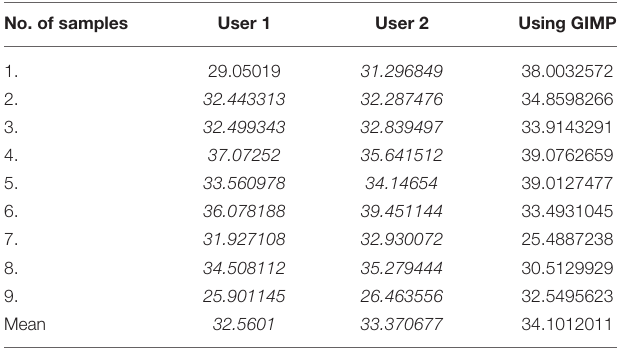
TABLE 3 | Bone area measurements using TWS by two different users and GIMP analysis (in %).